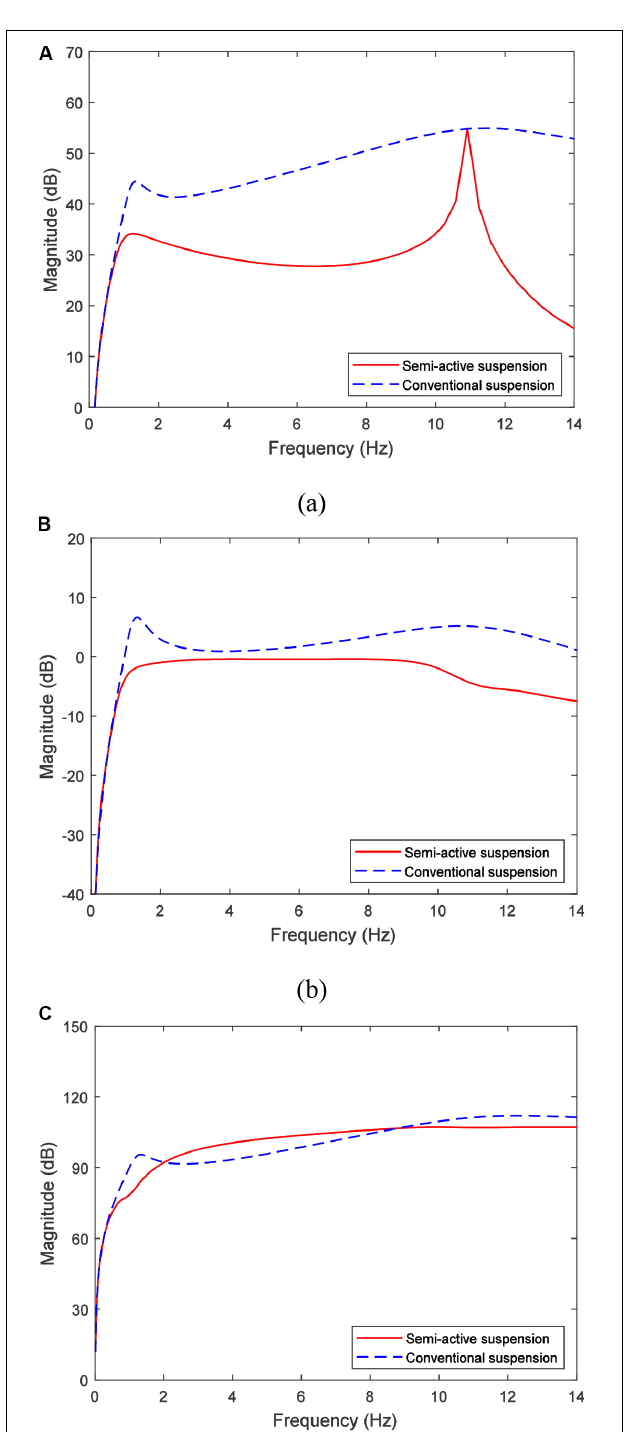
FIGURE 13 | Frequency response of the 1/4 vehicle suspension: (A) vehicle body acceleration, (B) suspension deflection, and (C) dynamic tire